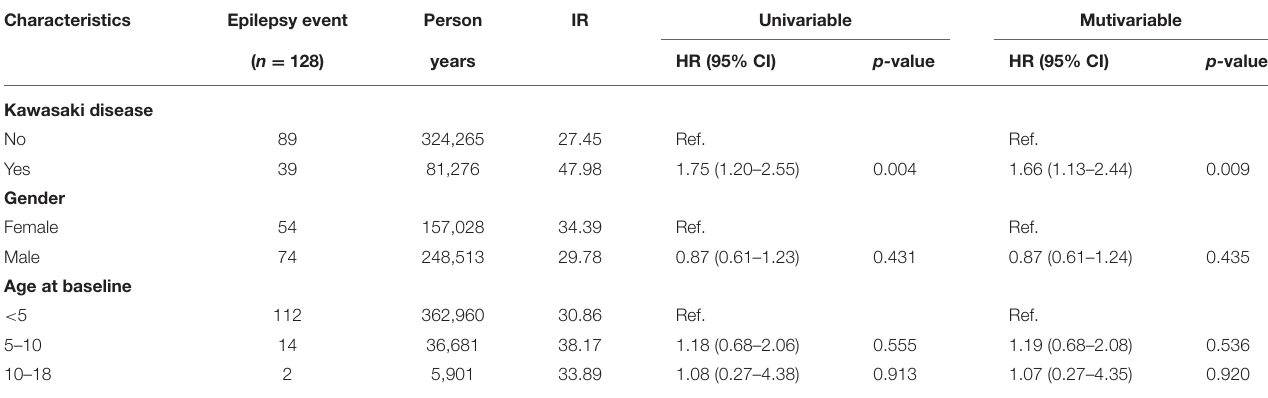
TABLE 2 | Cox model measured hazard ratio and 95% confidence intervals of epilepsy associated with and without Kawasaki disease. Characteristics